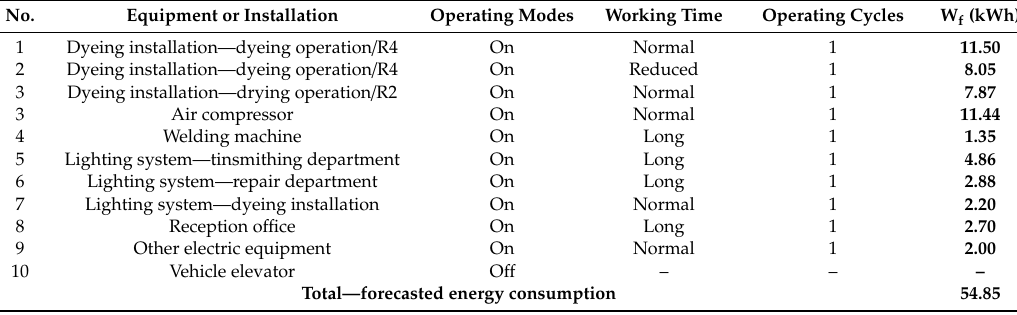
Table A5. The Decision Matrix and forecasted energy consumption for Thursday.